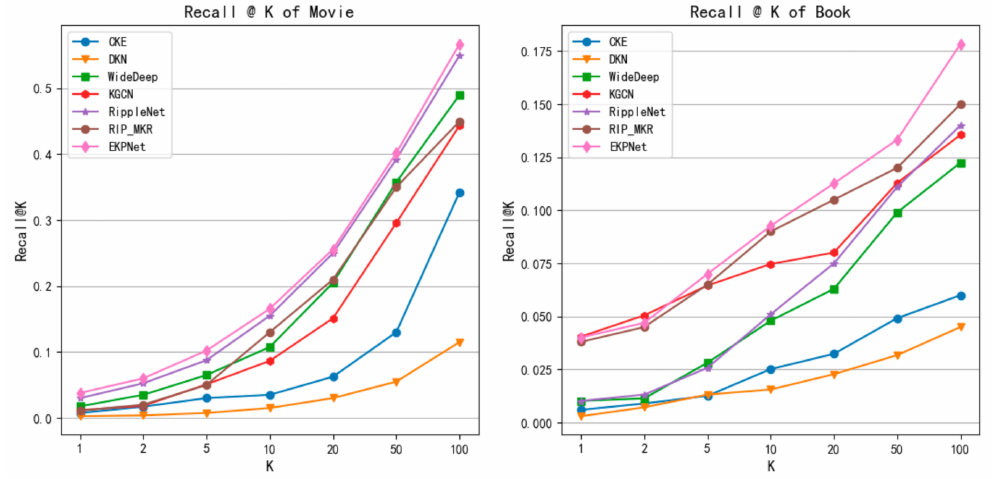
Figure 5. Recall@K of different baselines in the two datasets in the topK